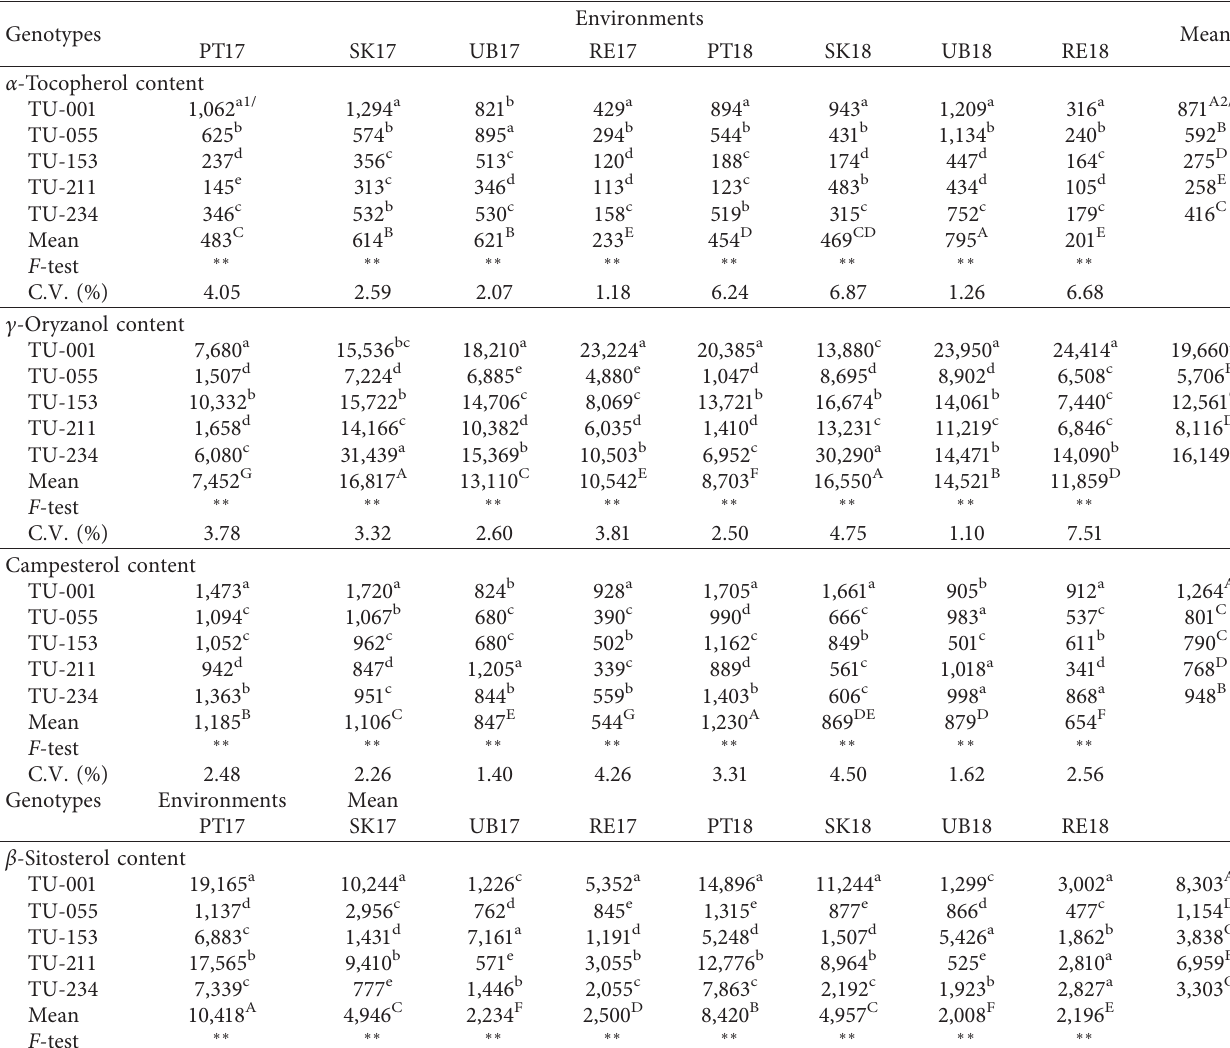
Table 4: Nutraceutical lipid compounds of five pigmented rice genotypes evaluated across eight environments during 2017-2018.